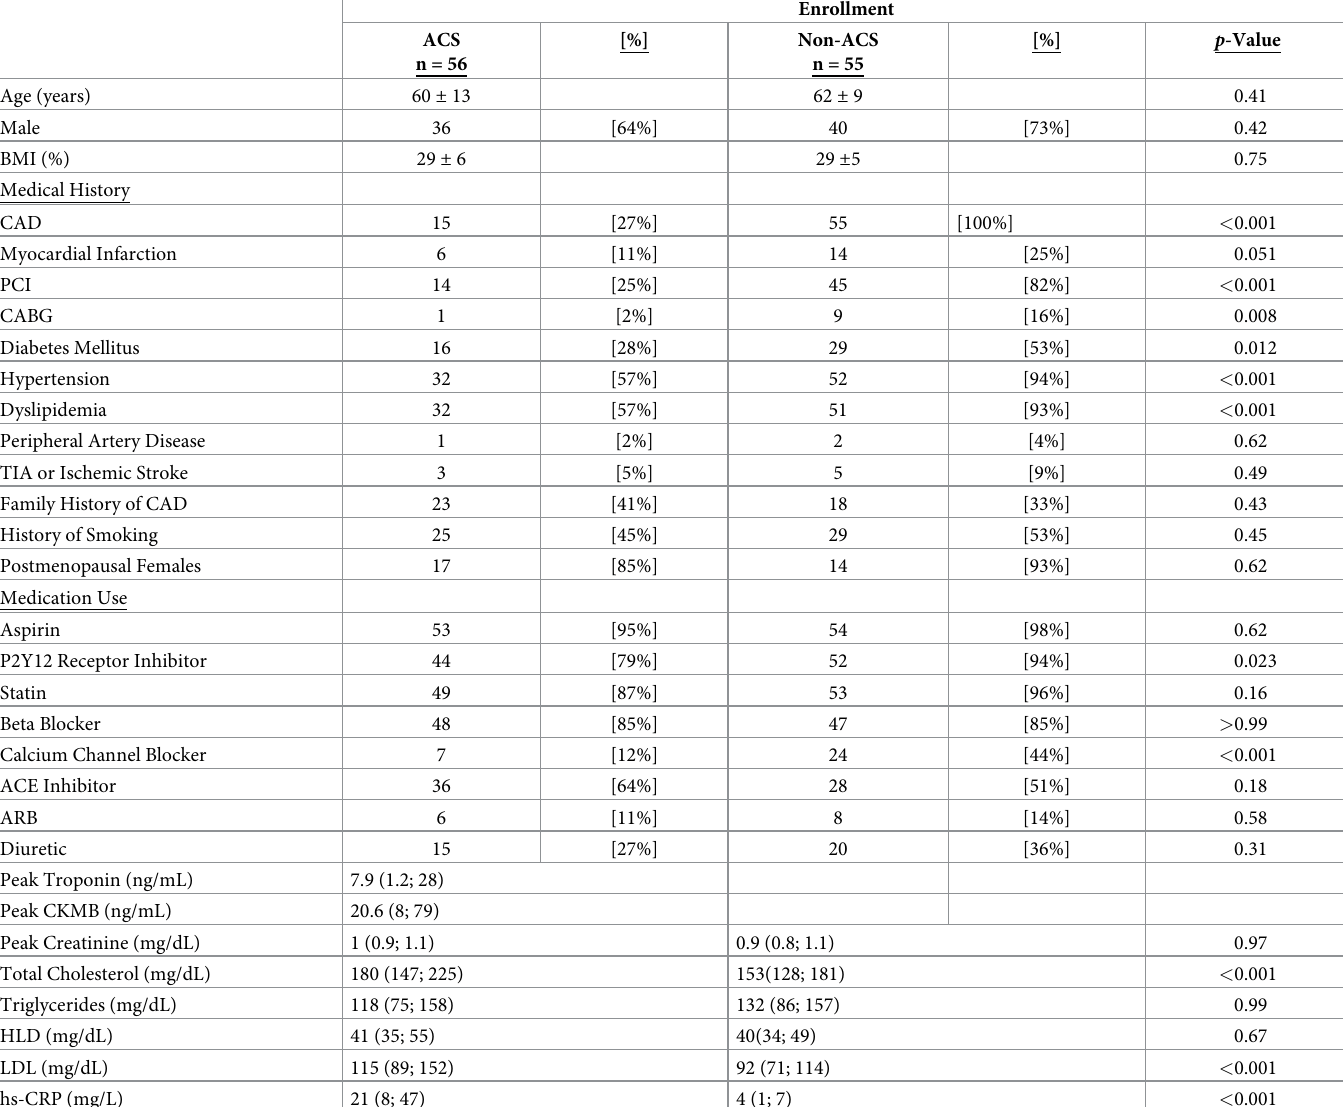
Table 1. Baseline characteristics and three-month follow-up of medication